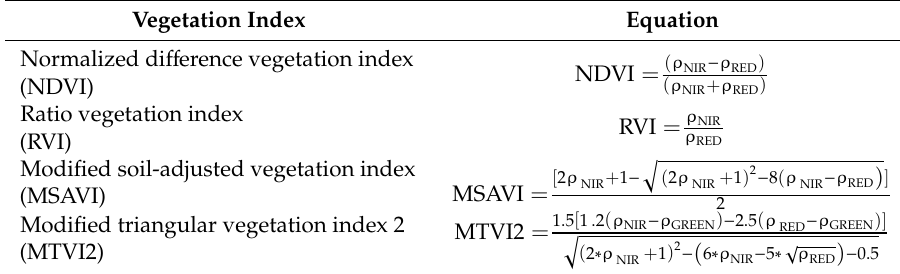
Table 1. Equations for the vegetation indices used in this study. ρ NIR , ρ RED , and ρ GREEN represent the reflectances of the Landsat images in the near-infrared, red, and green bands,